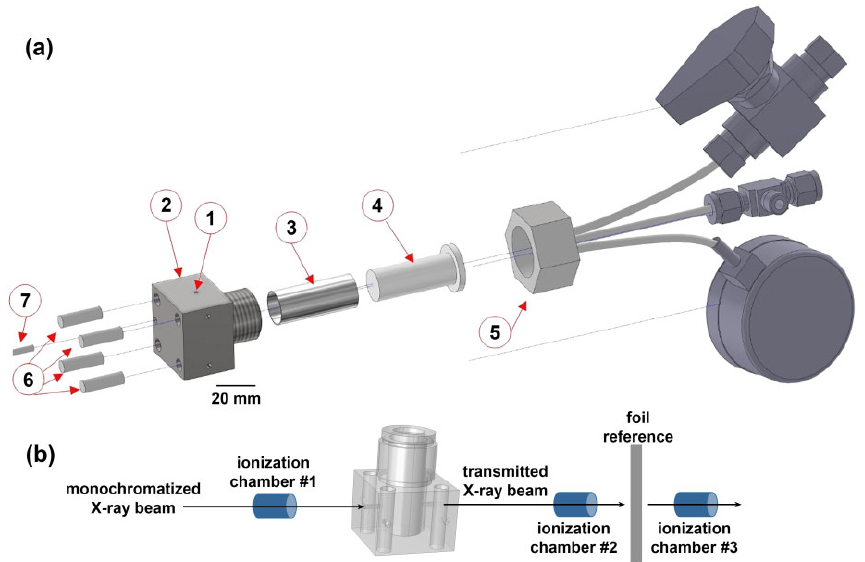
Figure 2. ( a ) Schematic view of the transmission cell. 1—hole, 2—cell body, 3—Al tube 0.5 mm thick,